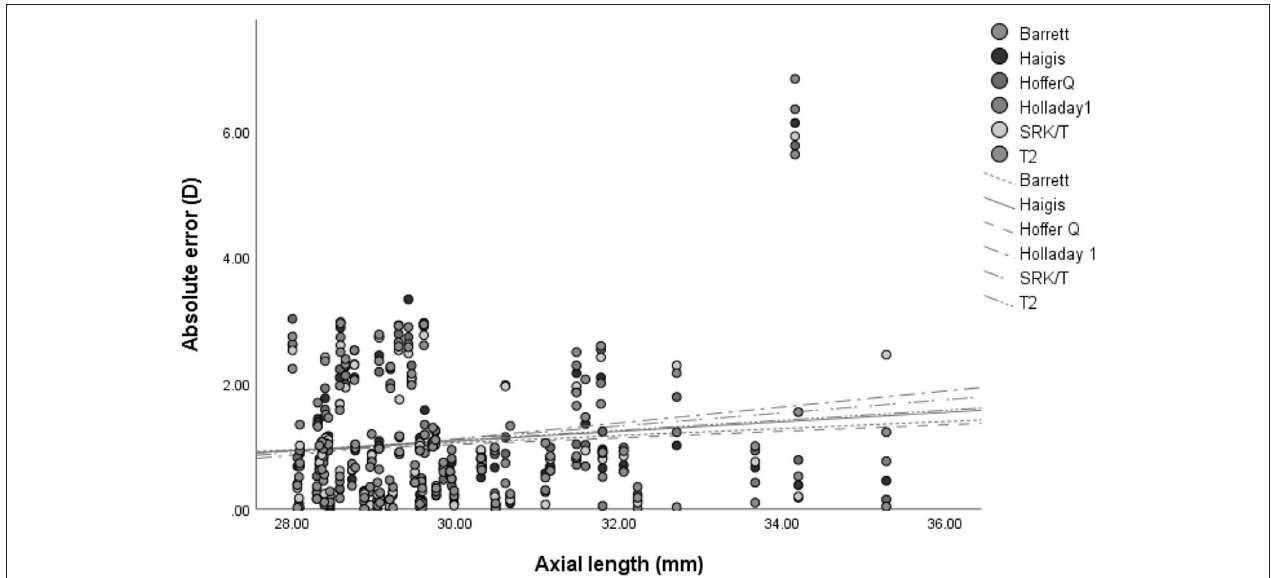
FIGURE 2 | The association between the absolute error of refractive outcome and axial length in 6 intraocular lens calculation formulas.